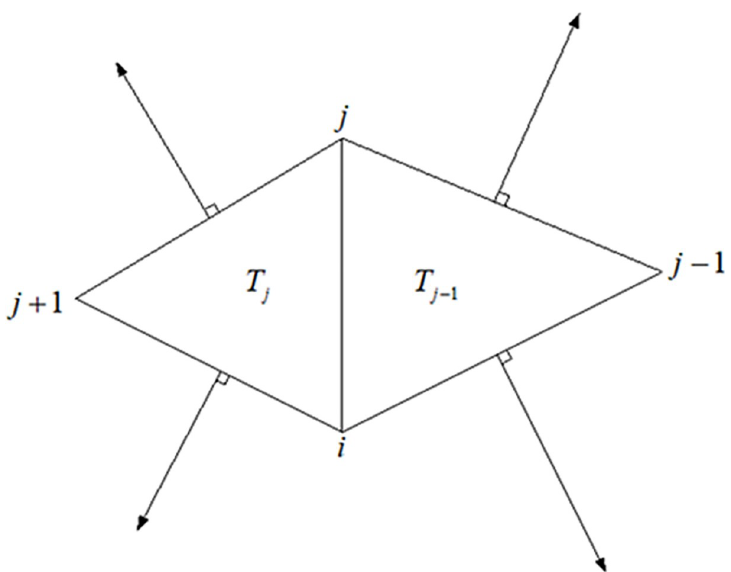
Fig 4. Illustration of coefficients of linear system of quasi-harmonic